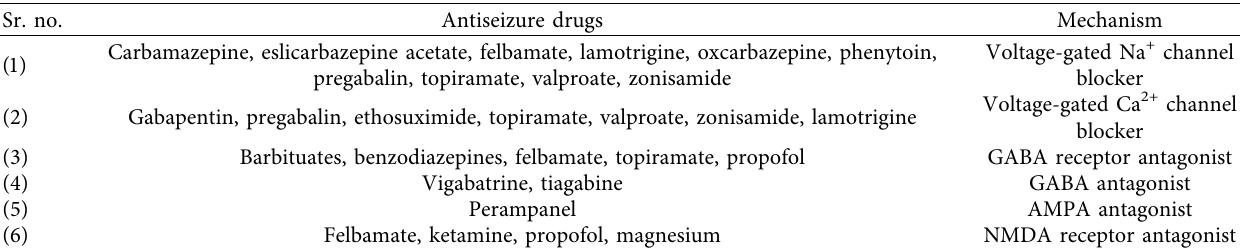
Table 4: Antiseizure drugs and their mechanism of action.